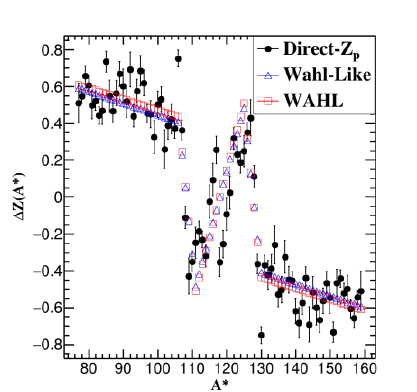
Fig. 4. Parameterization of the charge polarization based on Wahl’s systematics (in red), Wahl-like approach with uncertainties (in blue) and direct-Z p approach (in black).